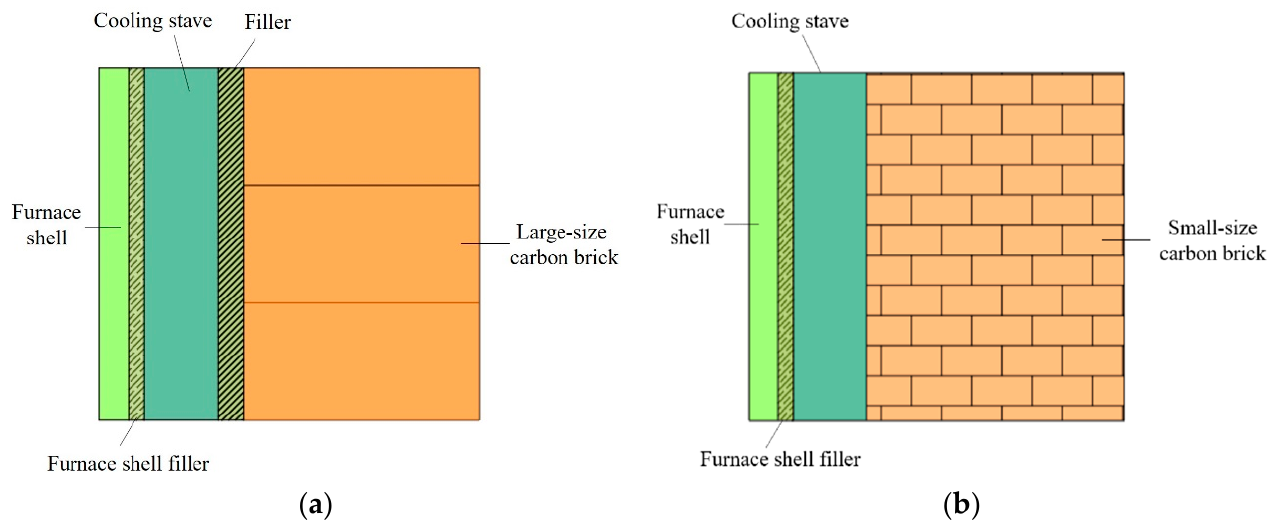
Figure 12. Schematic diagrams of the hearth structures with ( a ) large-size carbon bricks and ( b ) small-size carbon bricks.